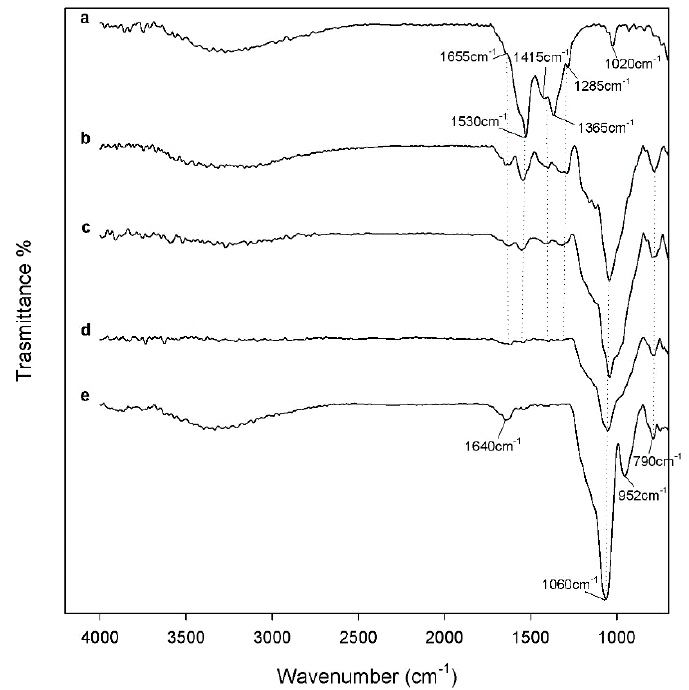
Figure 3. Attenuated total reflectance Fourier transform infrared (ATR-FTIR) spectroscopy spectra of ( a ) pure ZrO 2 , ( b ) 50 wt.% SiO 2 /ZrO 2 , ( c ) 33 wt.% SiO 2 /ZrO 2 , ( d ) 20 wt.% SiO 2 /ZrO 2 and ( e ) pure SiO 2 .